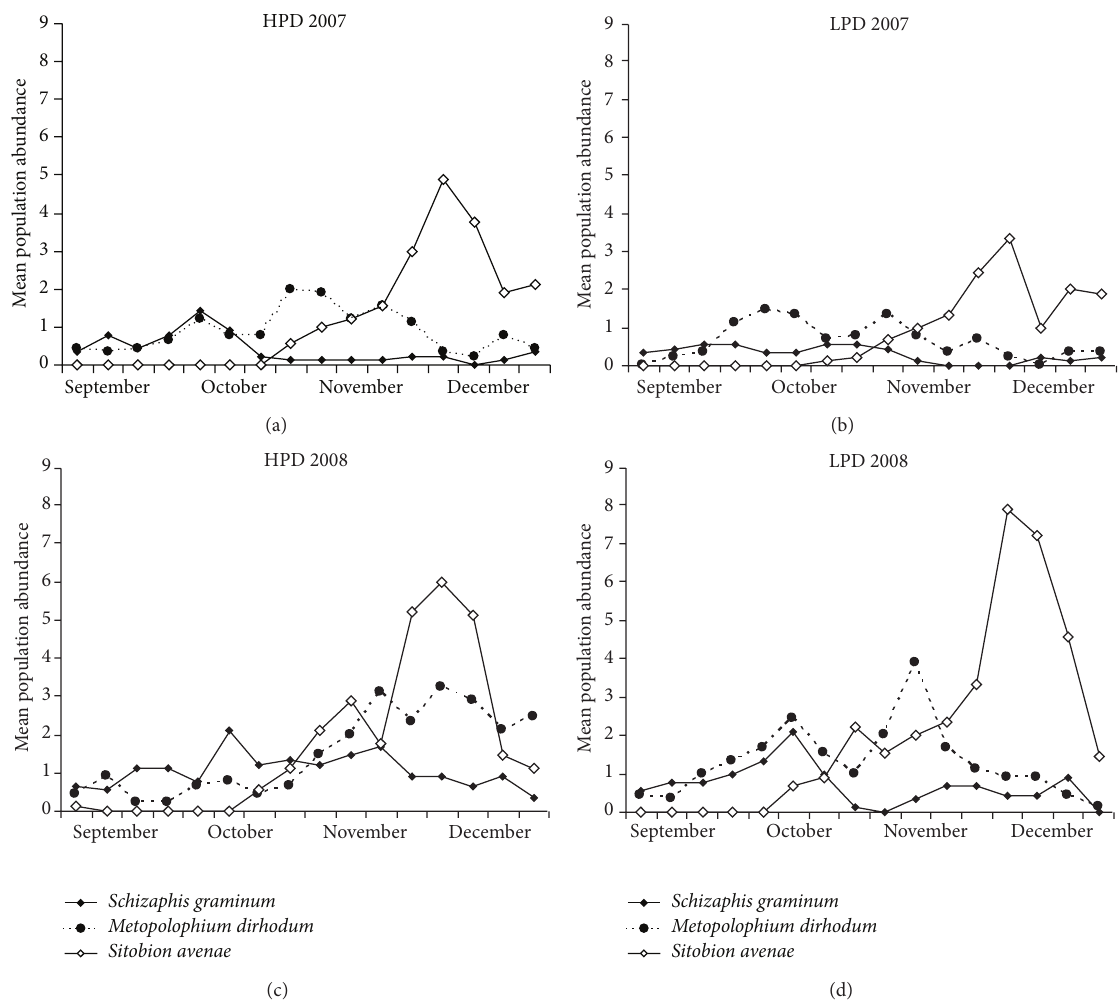
Figure 2: Mean population abundance of Schizaphis graminum , Metopolophium dirhodum, and Sitobion avenae in wheat crops with a high (HPD) and low plant diversity (LPD). Balcarce, 2007 and